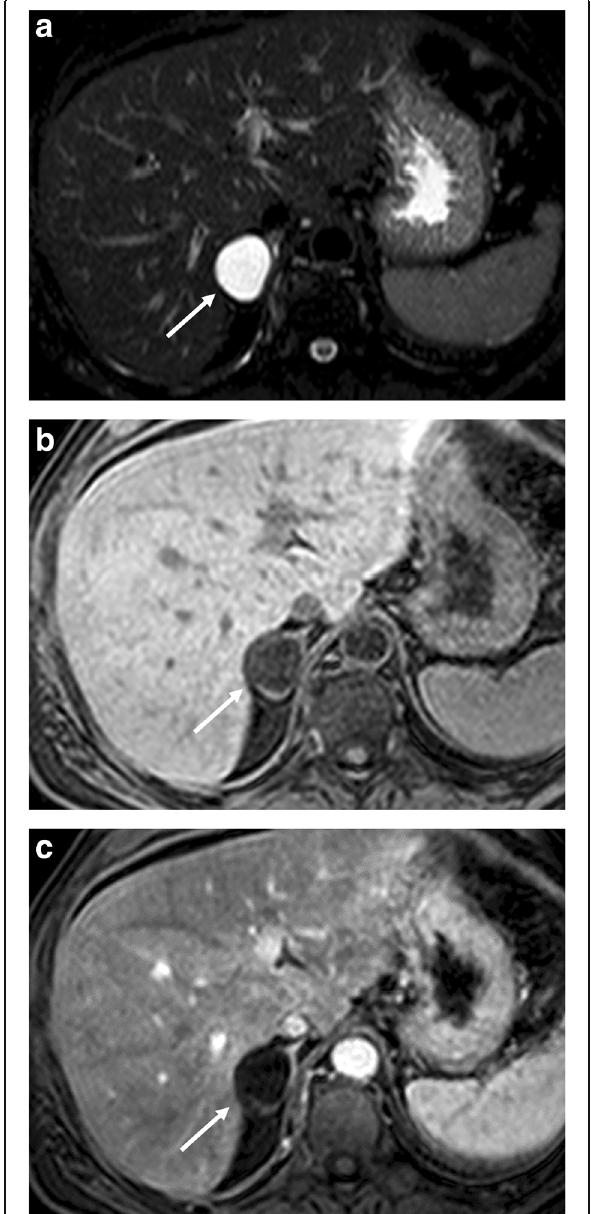
Fig. 4 Right adrenal cyst in a 50-year-old woman. Axial T2-weighted fat-saturated fast spin echo MR image ( a ), three-dimensional fat- suppressed T1-weighted gradient recalled echo images before ( b ) and after paramagnetic contrast administration ( c ) show a right adrenal cystic lesion (arrow) with low T1 signal intensity, high T2 signal intensity, no contrast enhancement and no septations, blood products, soft-tissue components, or